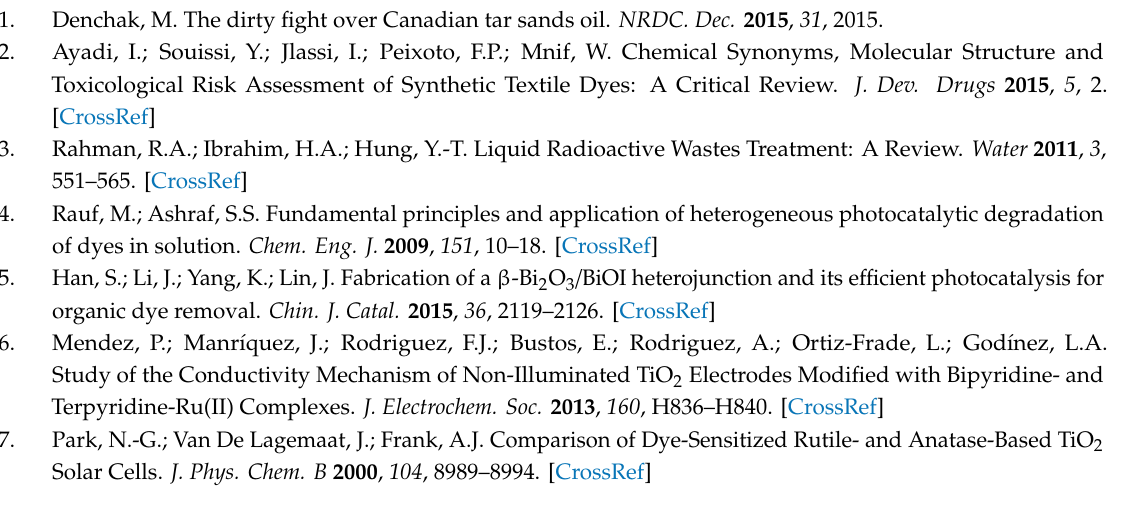
Figure S1: Schematic of experimental setup, Figure S2: Absorption spectra for MB dye degradation under neutral conditions for (a) TiO 2 , (b) 2.5% AgFeO 2 / rGO / TiO 2 and (c) 5% AgFeO 2 / rGO / TiO 2 , Figure S3: Absorption spectra for MB dye degradation for 2.5% AgFeO 2 / rGO / TiO 2 under (a) neutral, (b) acidic and (c) basic conditions, Figure S4: Absorption spectra for MB dye degradation for 5% AgFeO 2 / rGO / TiO 2 under (a) neutral, (b) acidic and (c) basic